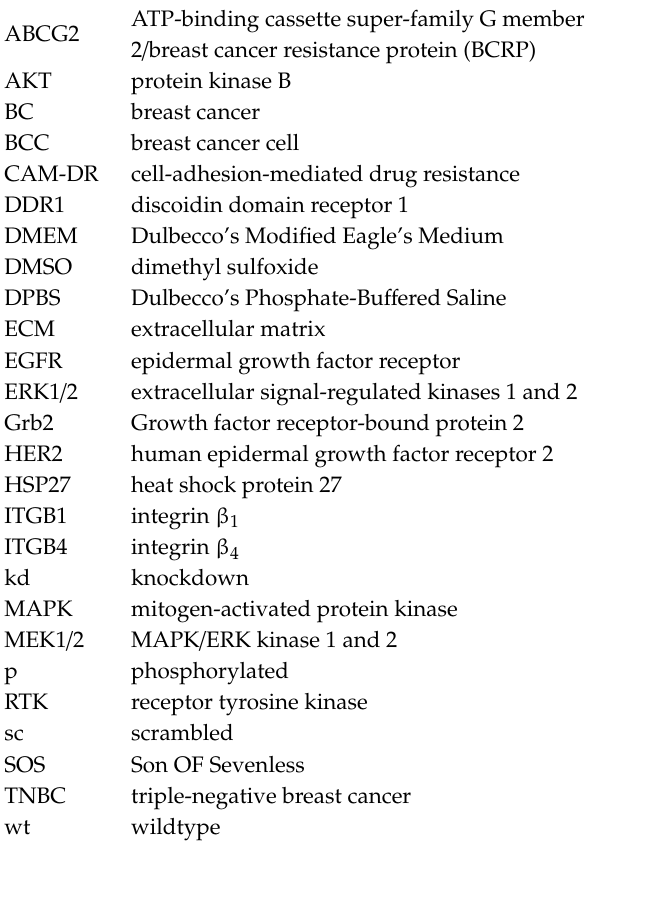
Figure S1. Annexin V / PI assay. Figure S2. Combination e ff ect of 7rh and SCH772984 cytotoxicity in MCF-7 cells. Figure S3. The impact of ERK1 / 2, MEK1 / 2 and DDR1-inhibitors on the cytotoxic treatment of MDA-MB-231